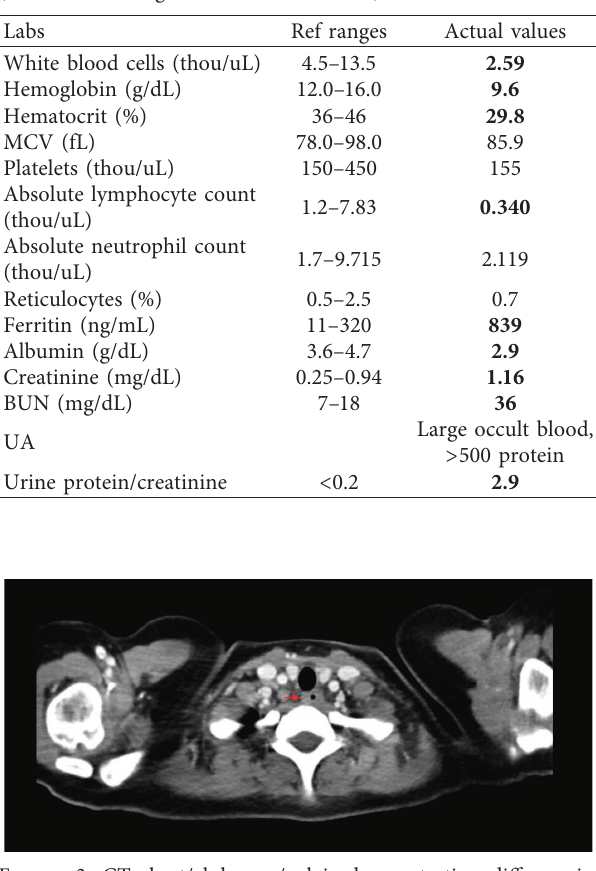
Table 2: Rheumatologic workup (abnormal findings are indicated in